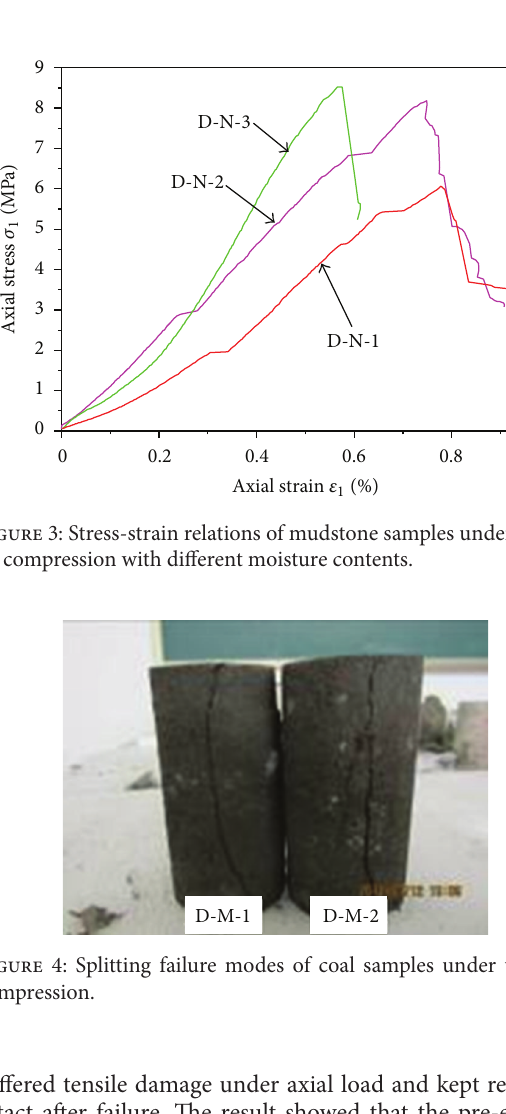
Figure 2: Failure modes of mudstone samples under uniaxial compression with different moisture contents.